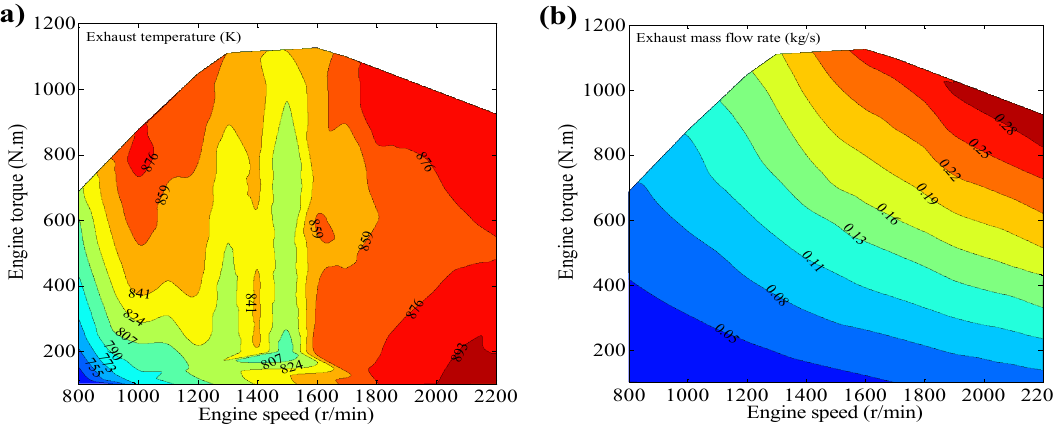
Figure 5. ( a ) The distributions of the exhaust temperature of the CNG engine; ( b ) The distributions of the exhaust mass flow rate of the CNG